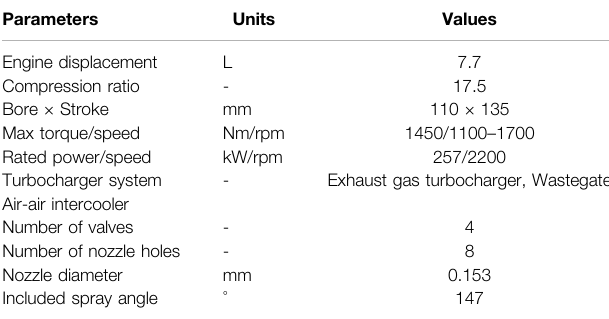
TABLE 1 | The experimental engine speci fi